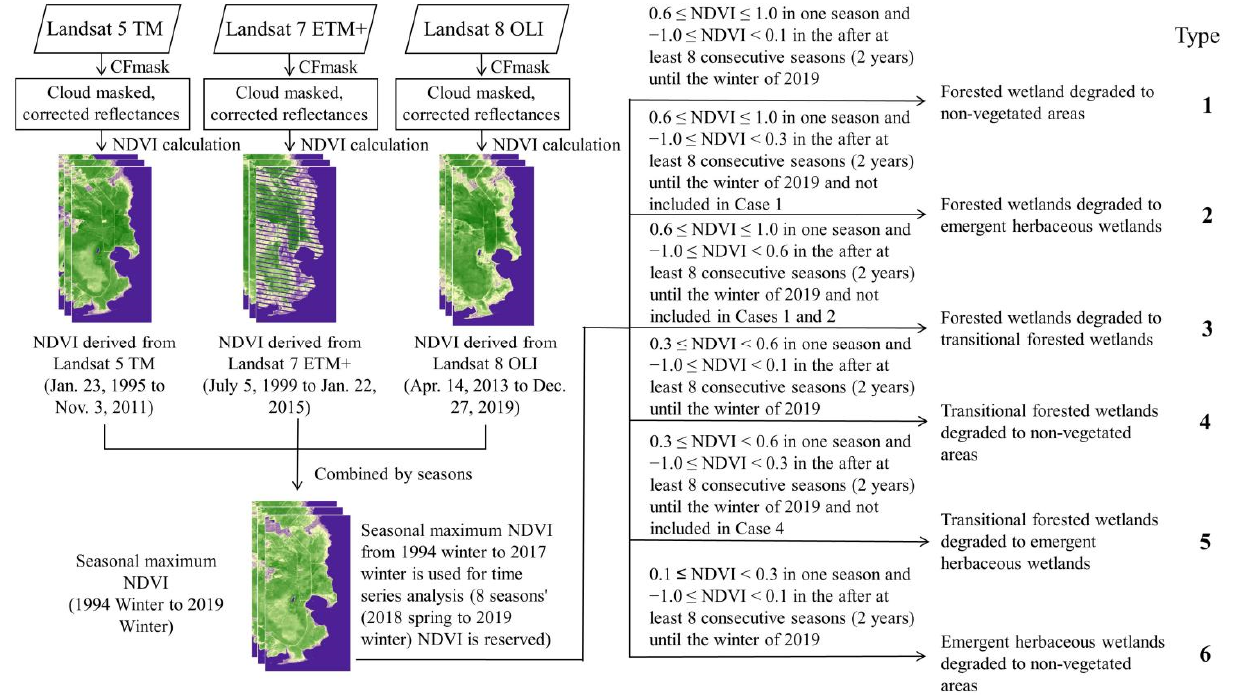
Figure 4. A framework of wetland degradation detection by analyzing seasonal NDVI time series derived from Landsat.